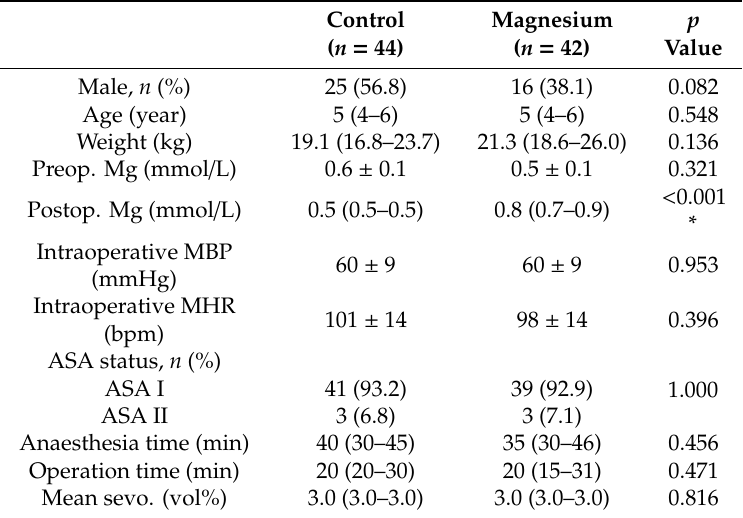
Table 2. Patient characteristics and diagnoses.